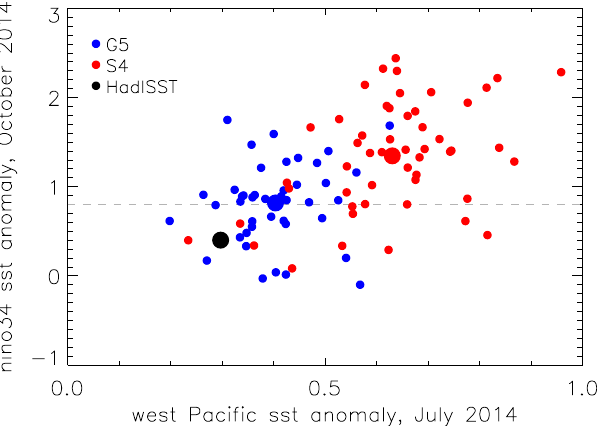
Figure 5. Relationship between El Niño and west Pacific SST for forecasts initialised May 2014. Scatter diagram of forecast ensemble members showing October Nino3.4 SST anomaly against July west Pacific SST anomaly for G5 (blue circles) and S4 (red circles). Ensemble means are large circles. Observations (black circle) are HadISST1.1. The dashed grey line indicates the 0.8 °C threshold. The west Pacific area (150°E-180°, 5°N-5°S) is shown in Fig. 2.